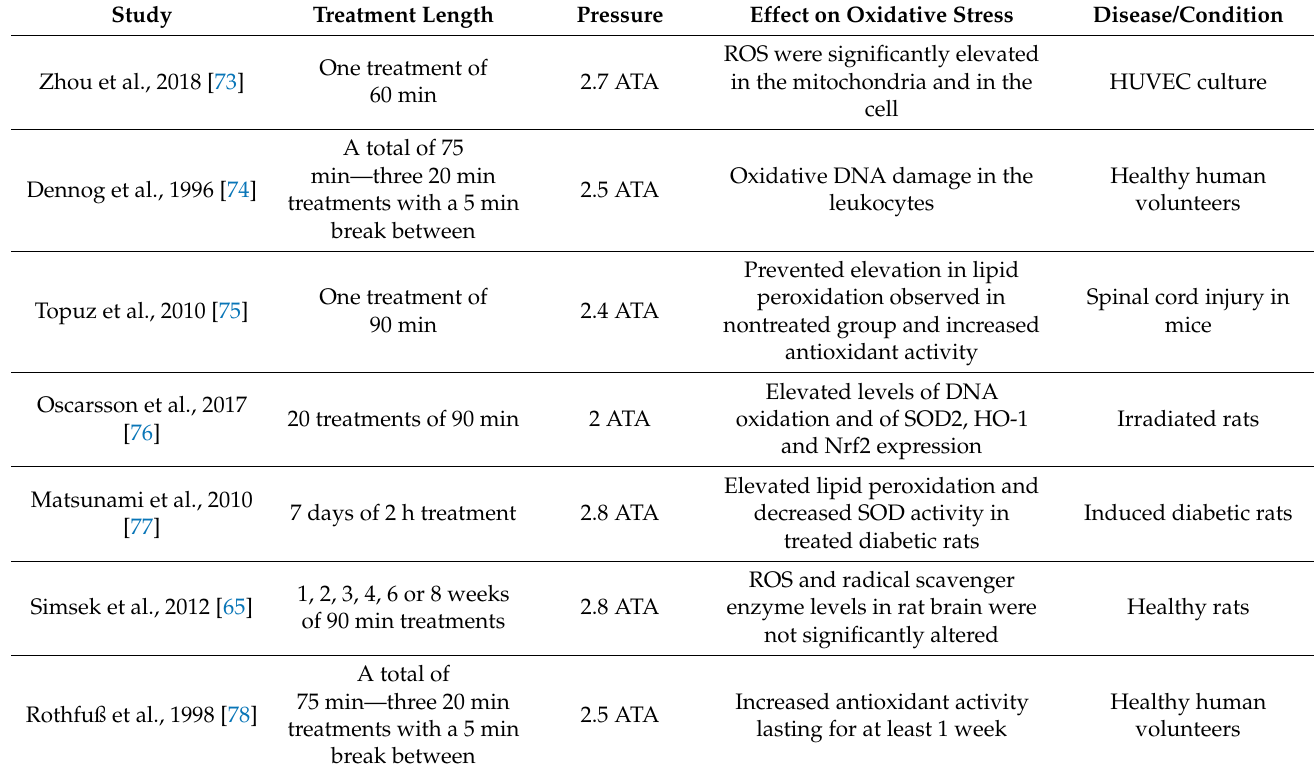
Table 2. Effects of HBOT on oxidative stress balance in different pathologies and protocols.